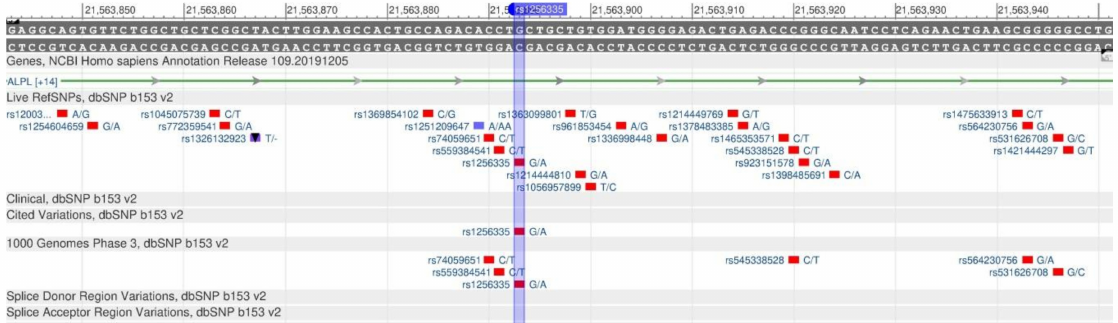
Figure 18. The ALPL gene region (located on the short (p) arm of chromosome 1) containing the oligonucleotide polymorphism